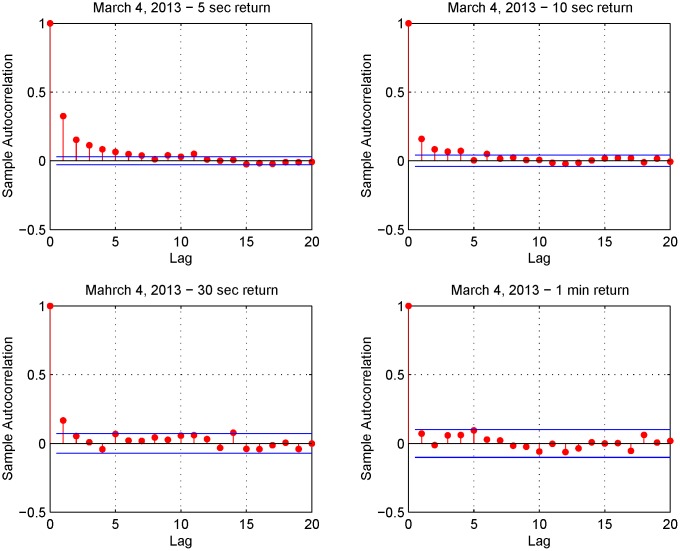
Autocorrelation for various sampling intervals on March 4, 2013.Upper left panel (5-second returns), upper right panel (10-second returns), lower left panel (30-second returns) and lower right panel (1-minute returns).